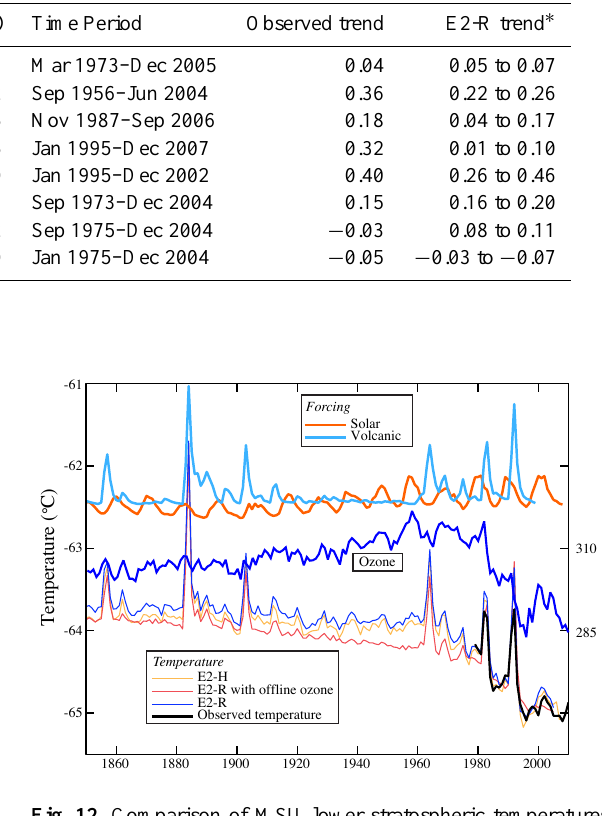
Fig. 12. Comparison of MSU lower stratospheric temperatures in model simulations and observations. Historical total column ozone (Dobson units; DU) and solar and volcanic forcing timeseries are shown for comparison (the vertical scale is arbitrary for